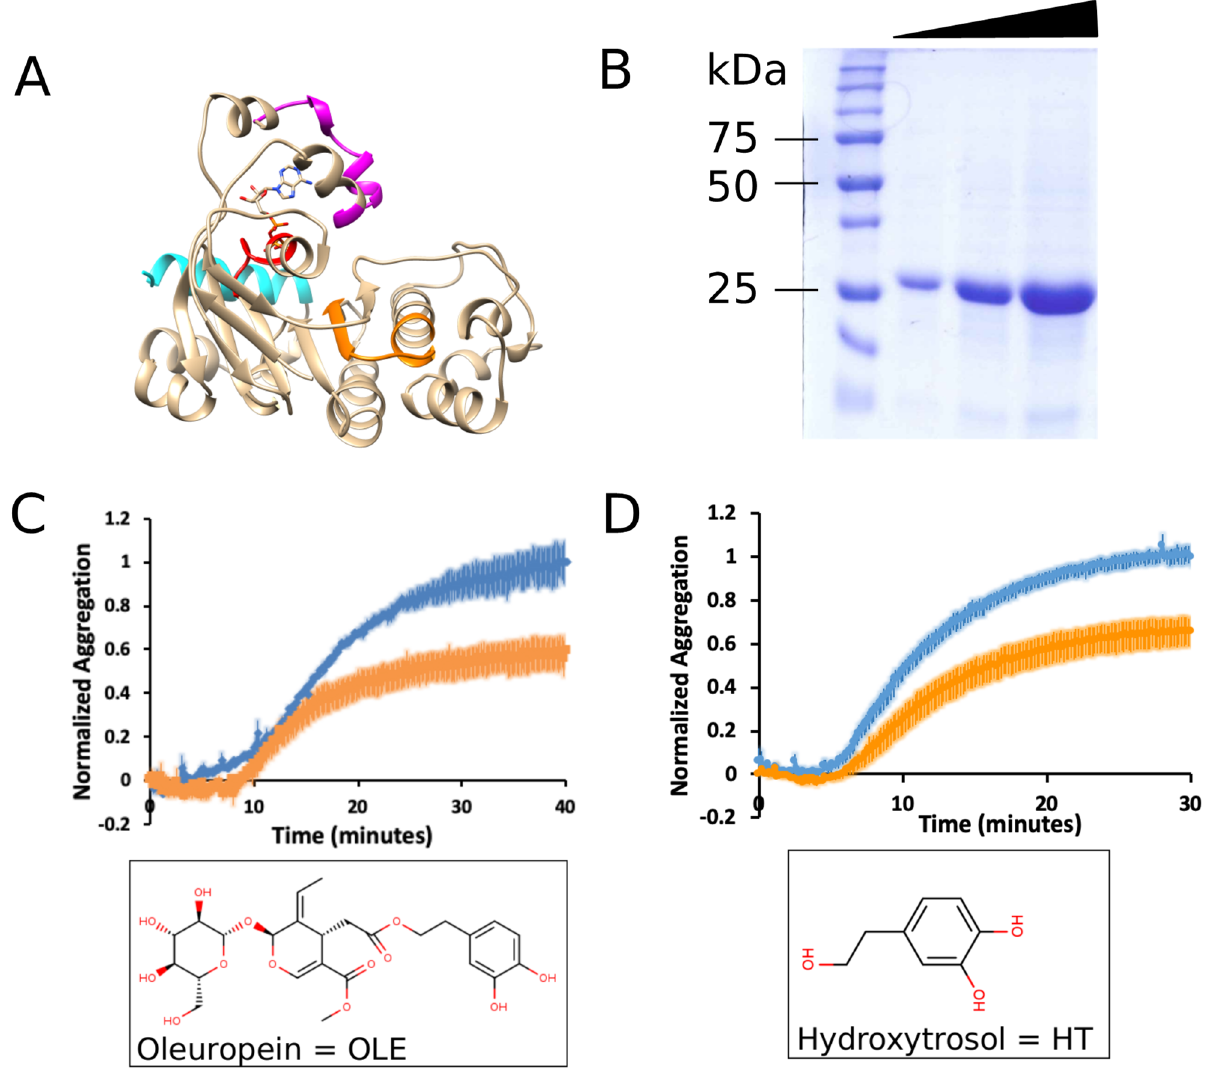
Figure 1. Oleuropein and Hydroxytyrosol suppress the aggregation of mNBD1- ∆ F508 in vitro. ( A ) X-ray crystallographic structure of CFTR mNBD1 (PDB:3SI7) bound with ATP and relevant motifs highlighted: Walker A (red), W alker B (orange), regulatory extension (cyan), and regulatory insertion (magenta). ( B ) Coomassie stained gel of purified mNBD1- ∆ F508 (residues 404–644) with increasing amounts of purified protein loaded (~5, 12, 25 µ g). ( C ) Aggregation of 2.5 µ M mNBD1- ∆ F508 measured by light scattering in the absence ( n = 2, blue) or presence of 100 µ M Oleuropein ( n = 4, orange), p -value = 0.0348. ( D ) Aggregation of 2.5 µ M NBD1- ∆ F508 in the absence ( n = 5, blue) or presence of 100 µ M Hydroxytyrosol ( n = 4, orange), p -value = 0.0017. Absorbance values were normalized to control at the 40-min (Oleuropein) or 30-min (Hydroxytyrosol) timepoints. Data plotted as mean ± SEM.